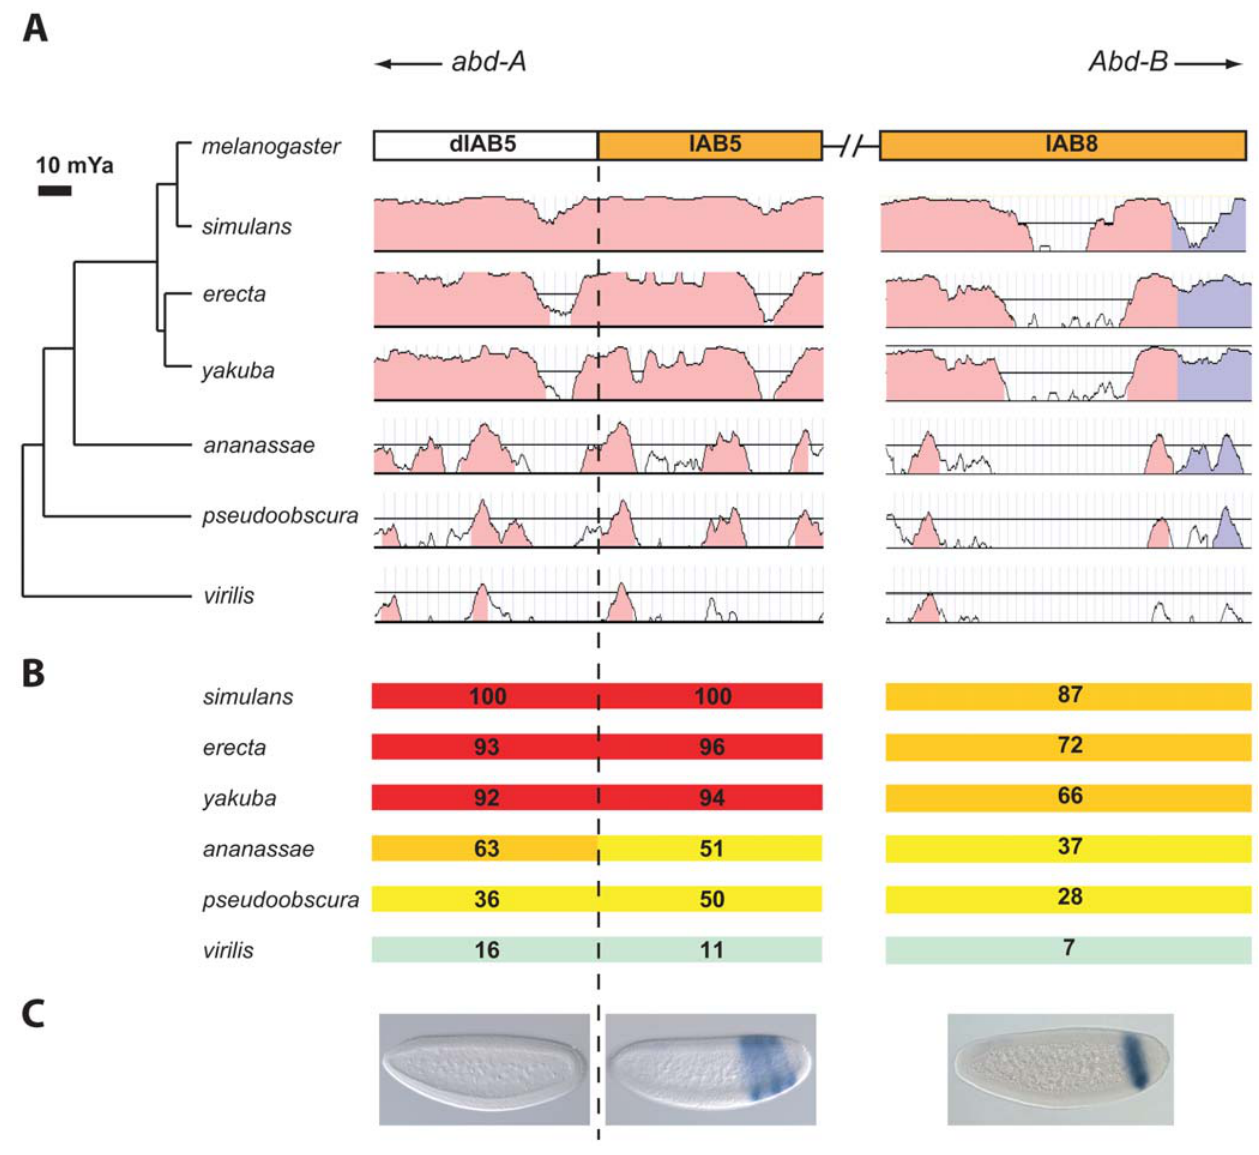
Figure 2. Spatial variation of conservation levels at the bithorax complex cis -regulatory modules. (A) VISTA plot of IAB5, dIAB5 and IAB8 genomic regions. The genomic location of the IAB5, dIAB5 and IAB8 regions relative to the neighboring Hox genes ( abd-A and Abd-B ) is indicated. Figures of sequence conservation level were generated by VISTA using default parameters. Conserved non-coding sequences ( . 70% sequence identity over a window of 100 bp) are indicated in pink. Conserved sequence in a region annotated as protein-coding is shown in blue. However, the identified CG10349 sequence located in the IAB8 region currently has no known or predicted function. (B) Level of sequence conservation. Level of conservation between sequences from D. melanogaster and six other Drosophila species is indicated by color code: . 90% red, 60–90% orange, 30– 60% yellow, , 30% green (calculation for conservation is detailed in Materials and Methods). (C) Enhancer regulatory activity in Drosophila embryos. The D. melanogaster dIAB5 genomic region (left) does not exhibit enhancer activity in D. melanogaster embryos in a transgenic assay (described in Materials and Methods). In contrast, the IAB5 (center) and IAB8 (right) D. melanogaster genomic regions drive lacZ reporter gene expression in the presumptive fifth, seventh and ninth abdominal segments or the presumptive eighth abdominal segment, respectively, in D. melanogaster